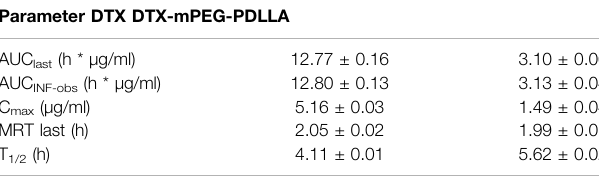
TABLE 1 | Pharmacokinetic parameters of the DTX and DTX-mPEG-PDLLA micelles after IP administration in